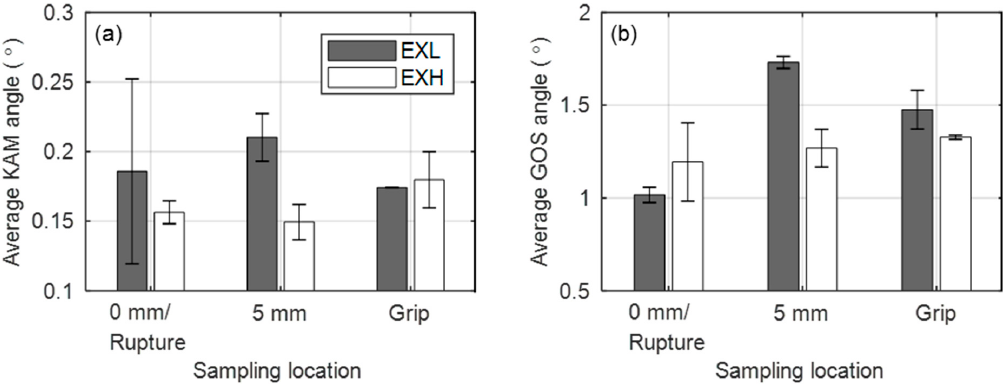
Figure 12. Average ( a ) KAM and ( b ) GOS angles for EXL and EXH material at various sampling locations in the specimen gauge regions.